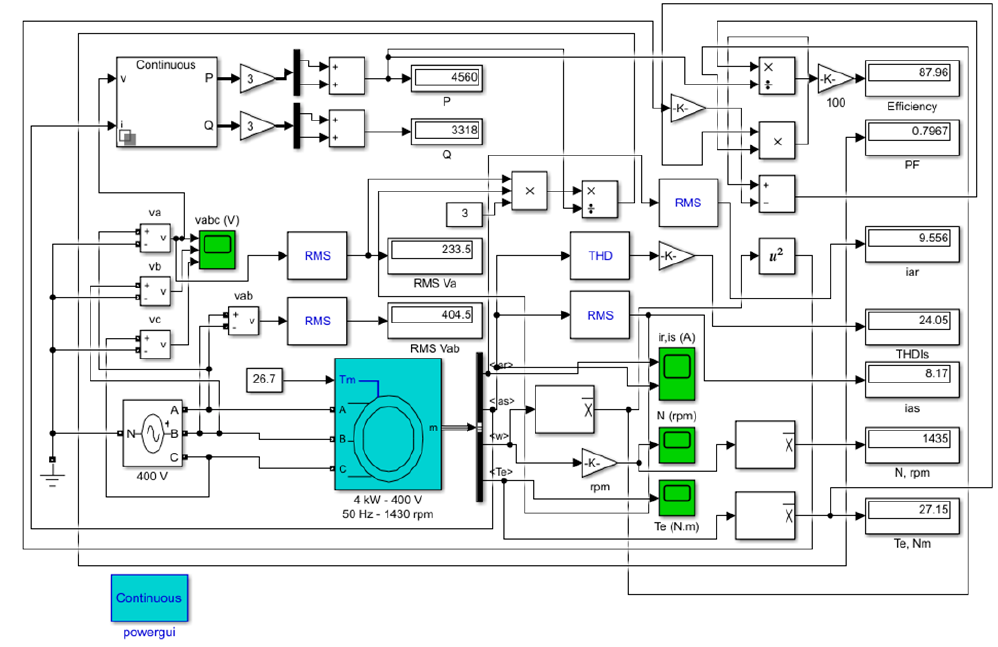
Figure 1. Simulation of the IM in MATLAB / Simulink.